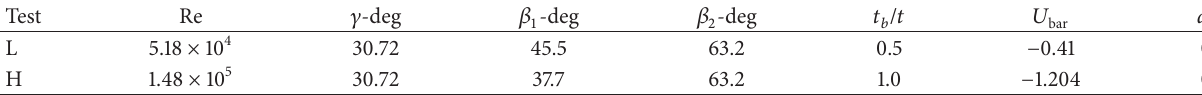
Table 1: Details of the blade geometry and conditions.